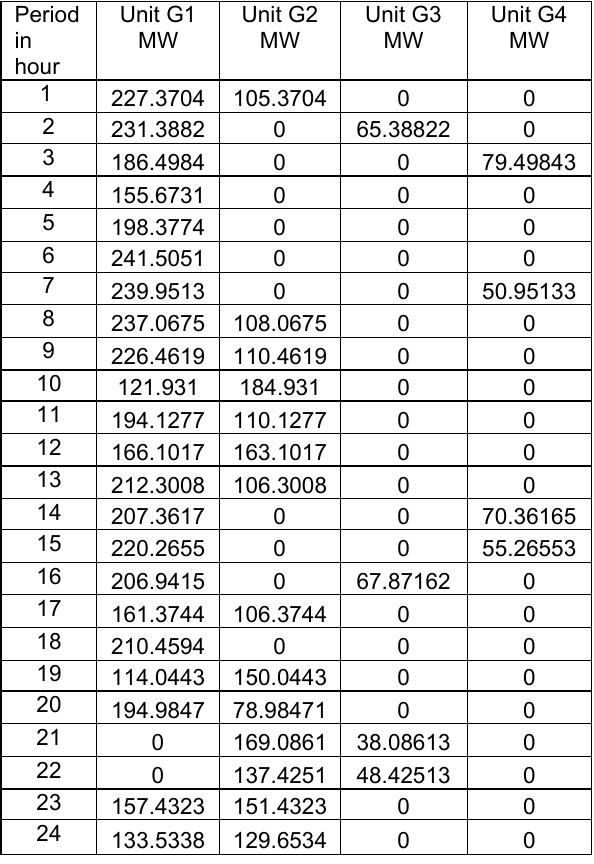
Table 4. Hour by Hour Load